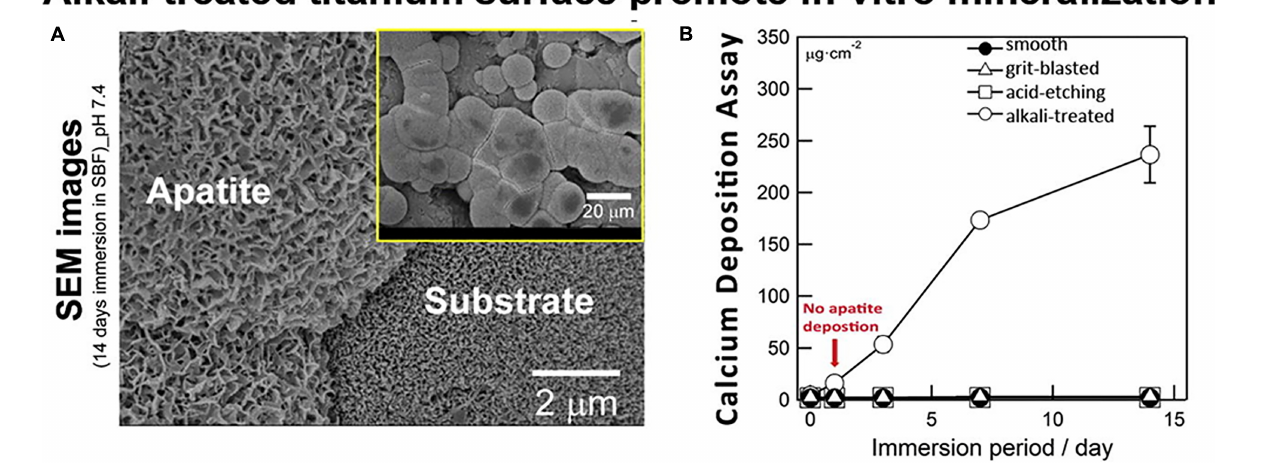
FIGURE 5 | (A) SEM images of all Ti disks with alkali-treated after immersion in SBF for 14 days and (B) The amount of calcium deposition onto all Ti disks with different surface treatments (untreated, grit-blasted, acid-etched, and alkali-treated) after immersion in SBF until 14 days (Camargo et al.,